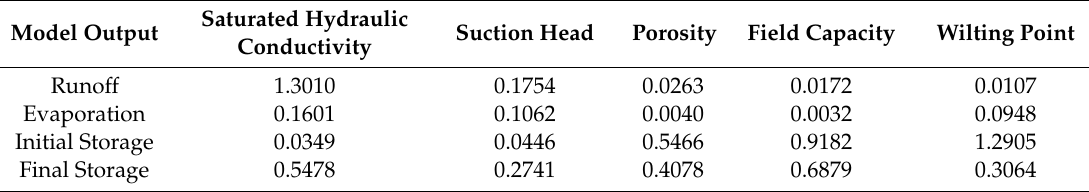
Table 4. Sensitivity of 5 soil